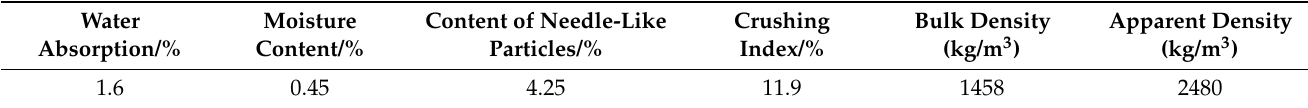
Table 4. Performance indexes of natural coarse